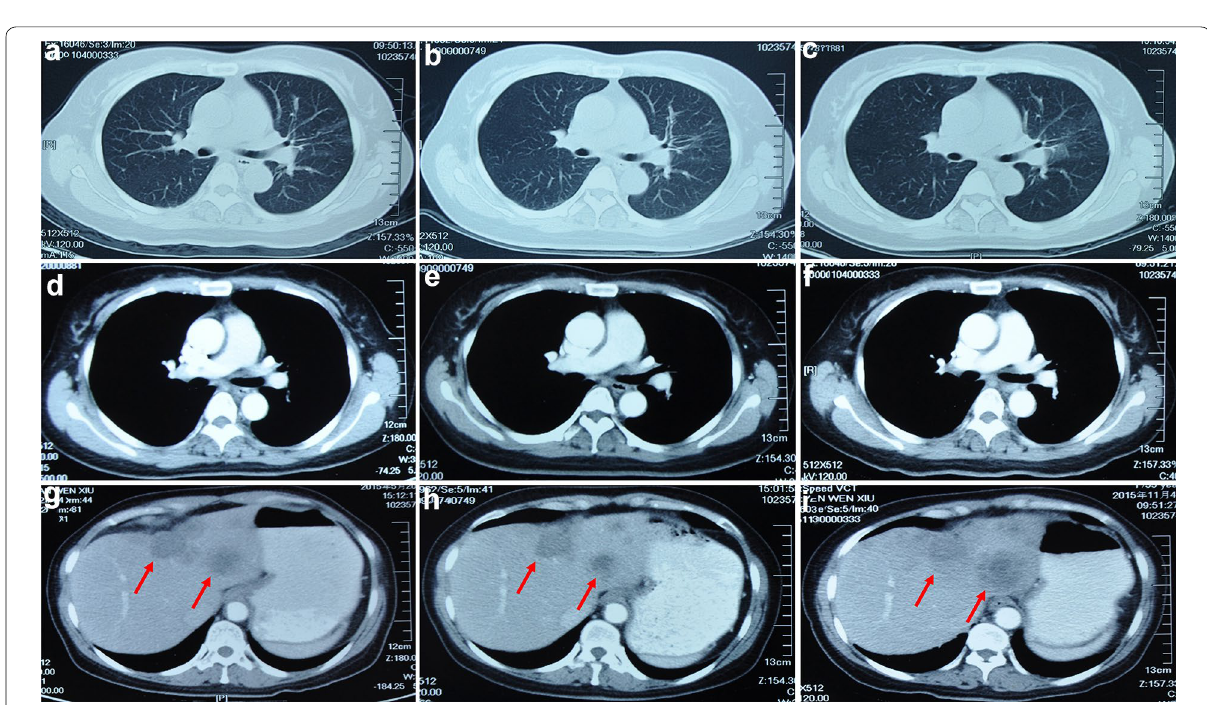
Fig. 6 Disease evaluation during the treatment of pemetrexed with bevacizumab. Before treatment of pemetrexed with bevacizumab, liver metas- tases were assessed using CT scan and no lung lesions were found ( a , d , and g ). After two cycle therapy of pemetrexed with bevacizumab, meta- static nodule size in liver decreased (partial response) ( b , e and h ). The CT scan showed the disease progression in liver metastases after eight cycle administration of pemetrexed plus bevacizumab ( c , f and i ). During the entire course, there were still no metastases in bilateral lungs, mediastinum, brain and so